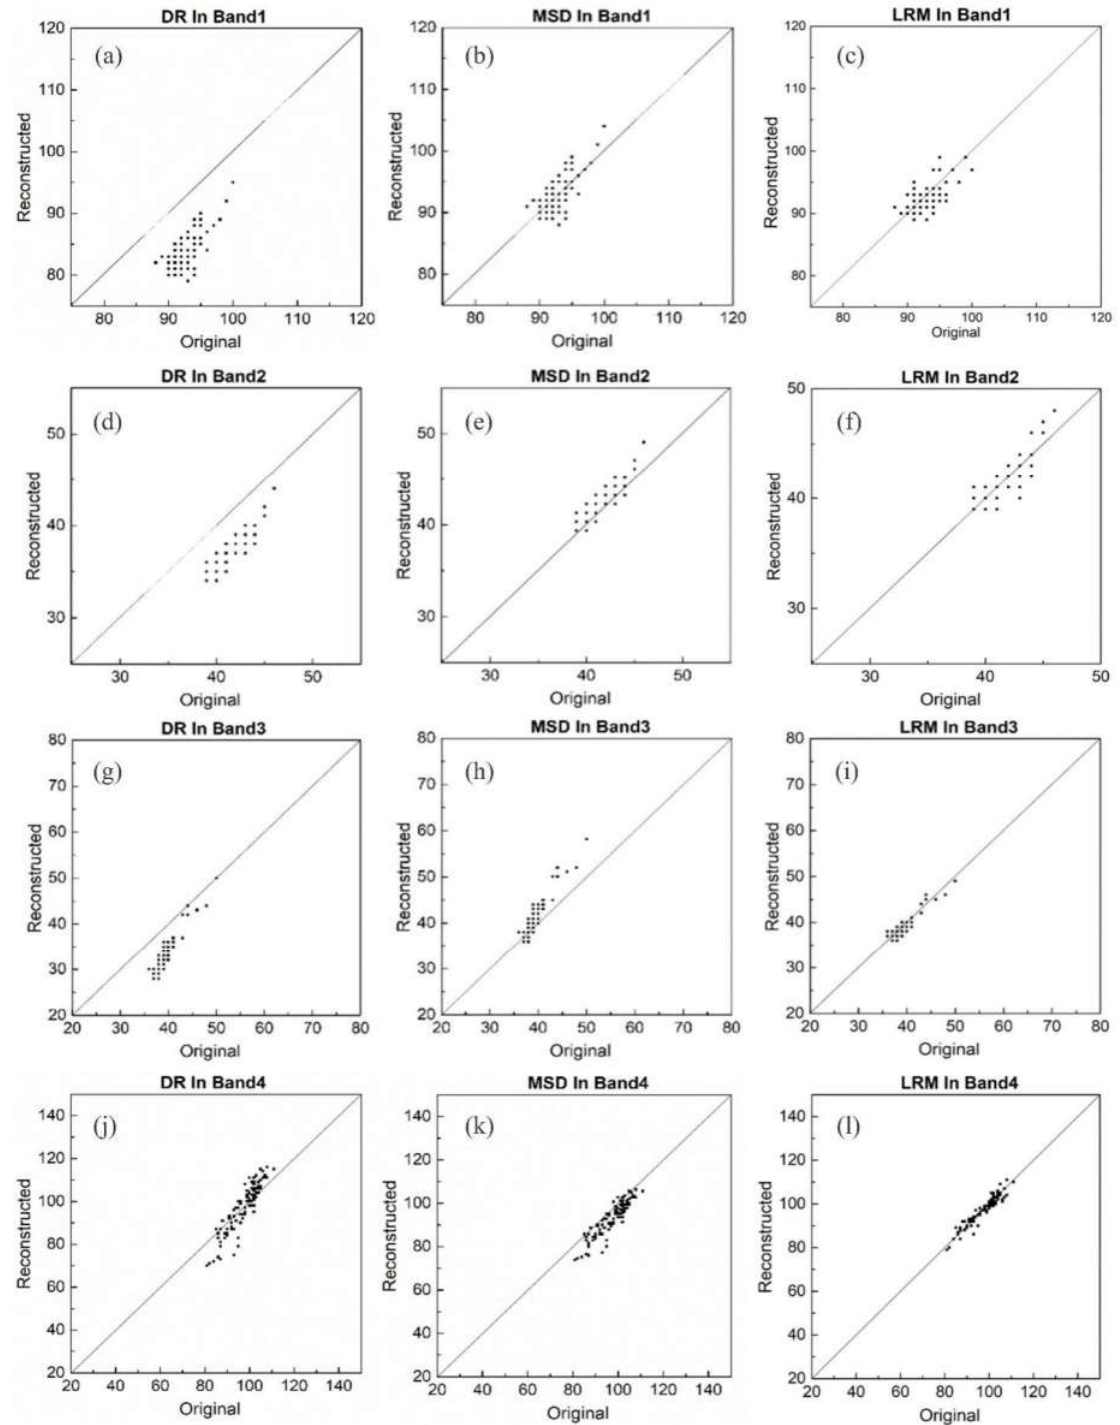
Figure 4. The scatter plots of the 3 methods for the 4 bands over the mountain surface patterns with ( a – c ) for band 1; ( d – f ) for band 2; ( g – i ) for band 3; ( j – l ) for band 4.